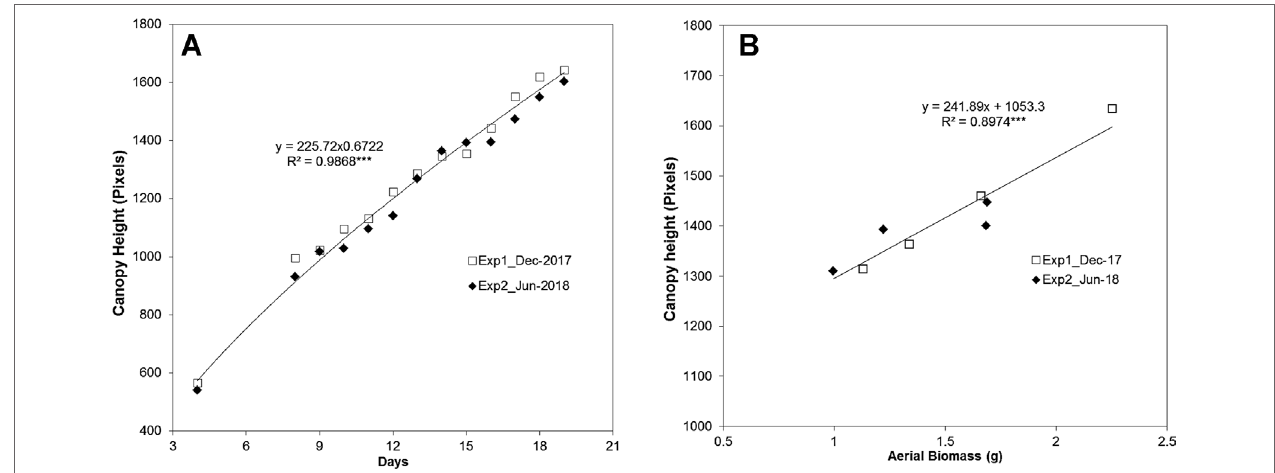
FIGURE 2 | Analysis of the reproducibility of canopy height estimation in barley ( Hordeum vulgare ) seedlings from two independent experiments. (A) The reproducibility of projected canopy height dynamics (in pixels) in barley seedlings (n = 100) grown under control conditions in December 2017 and July 2018. (B) The correlation between canopy height and fresh aerial biomass (g) (n = 5) determined for replicates measured at day 16 and day 19 in barley seedlings from the two independent experiments. The regression curve and significance calculated from three independent trays is shown. *** P ≤